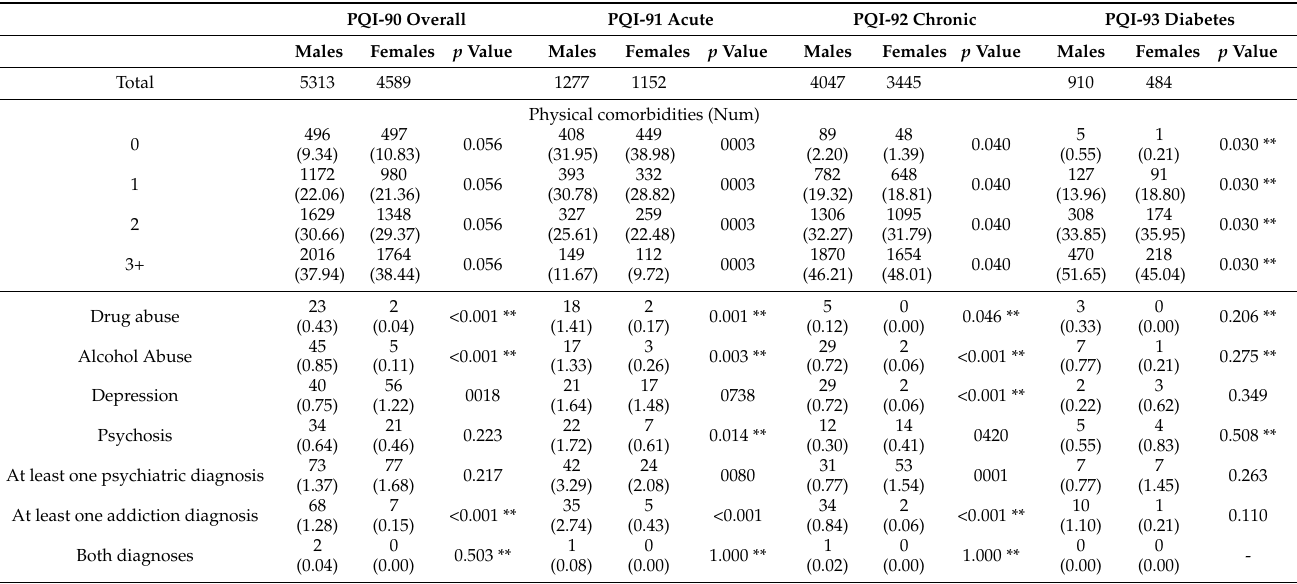
Table 3. Characteristics (physical comorbidities and mental health/substance use conditions) of the population by gender and by PQI. PQI-90